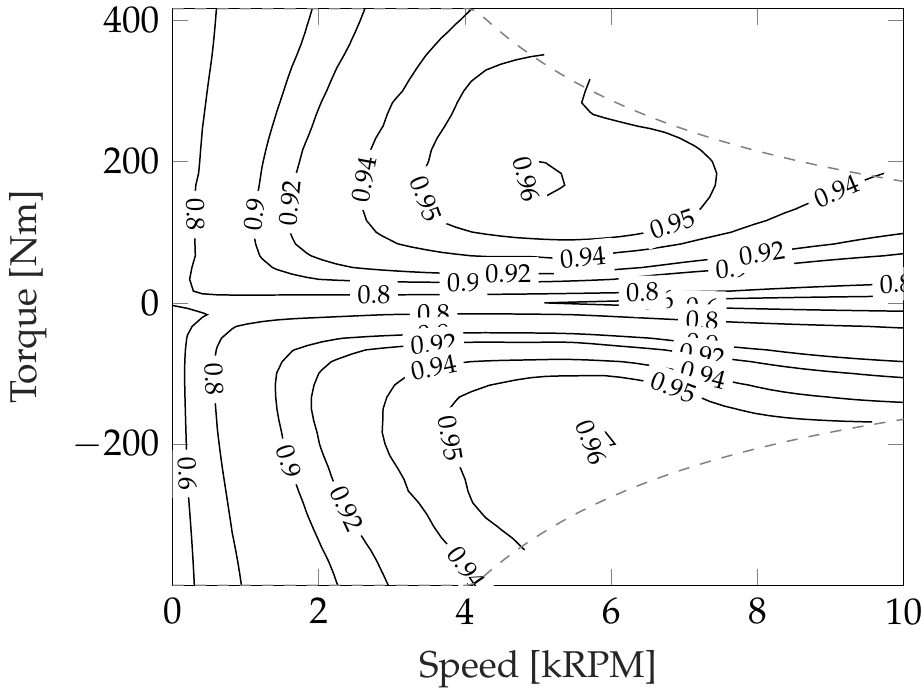
Figure 7. Efficiency map of the machine, including the inverter. The dashed line shows the constant power limit. Traction drives of different levels of rated power were evaluated in the drive cycle simulations. In order to achieve this, the efficiency map shown in Figure 7 was used though the y (torque) axis and rescaled to represent traction drives of different power ratings. In the following simulation study, this variation was extended from the measured machine (180 kW) +/ 40 −